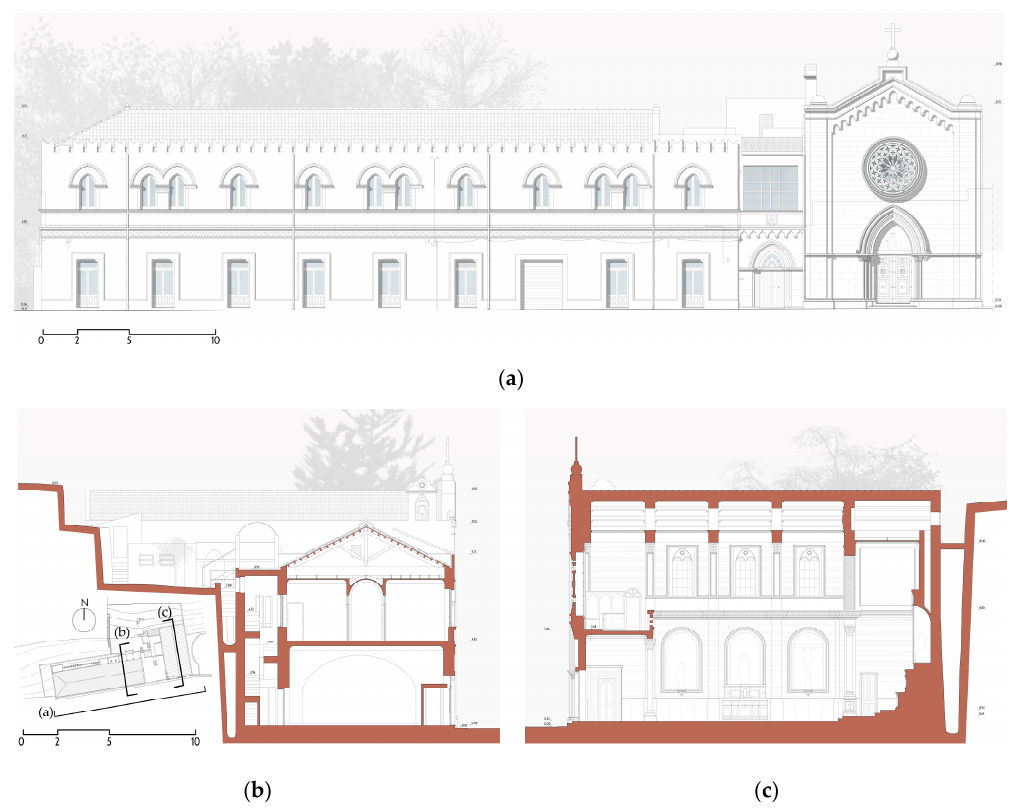
Figure 4. South elevation ( a ) and sections of the convent ( b ) and the church ( c ).